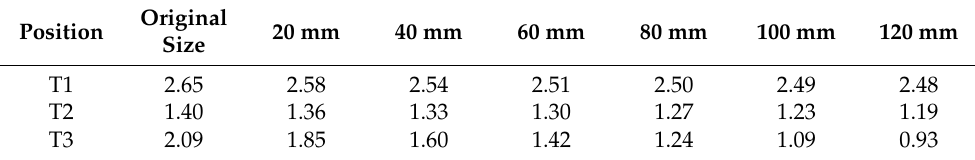
Table 12. Lengthen ILVT in the longitudinal direction (MPa).